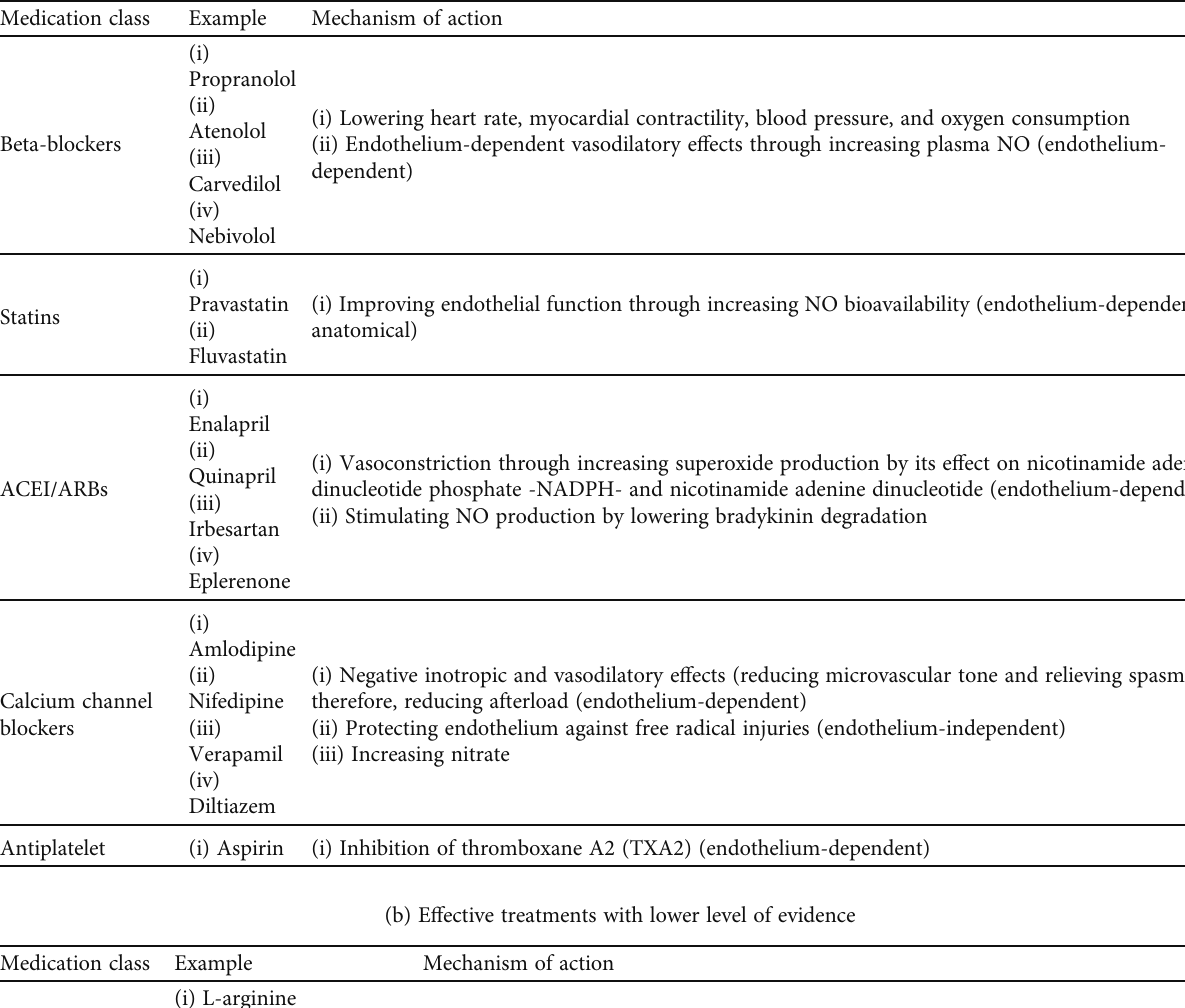
Table 2: Classi fi cation of drugs for management of microvascular angina and their proposed mechanisms; (a) fi rst line therapy or synergistic combination therapy; (b) e ff ective treatments with lower level of evidence; (c) less e ff ective